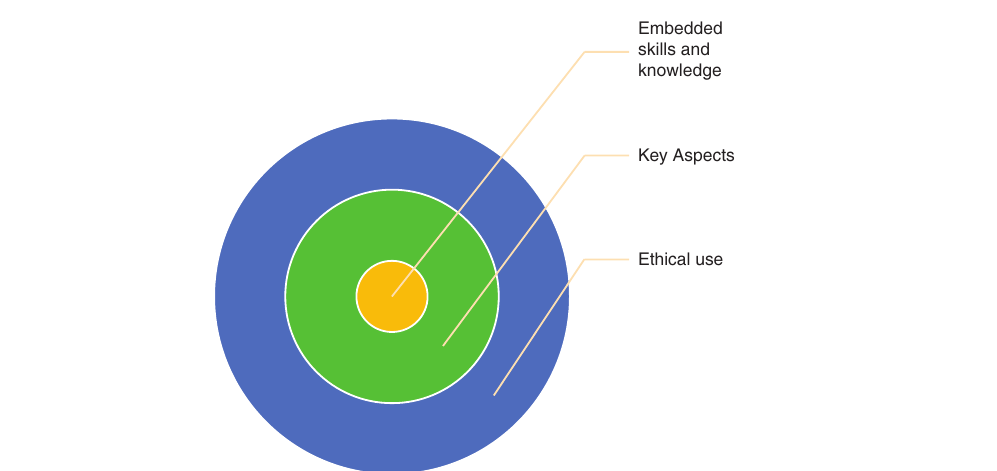
Figure 1: Relationship between ethical use of digital technology, key aspects and embedded skills and